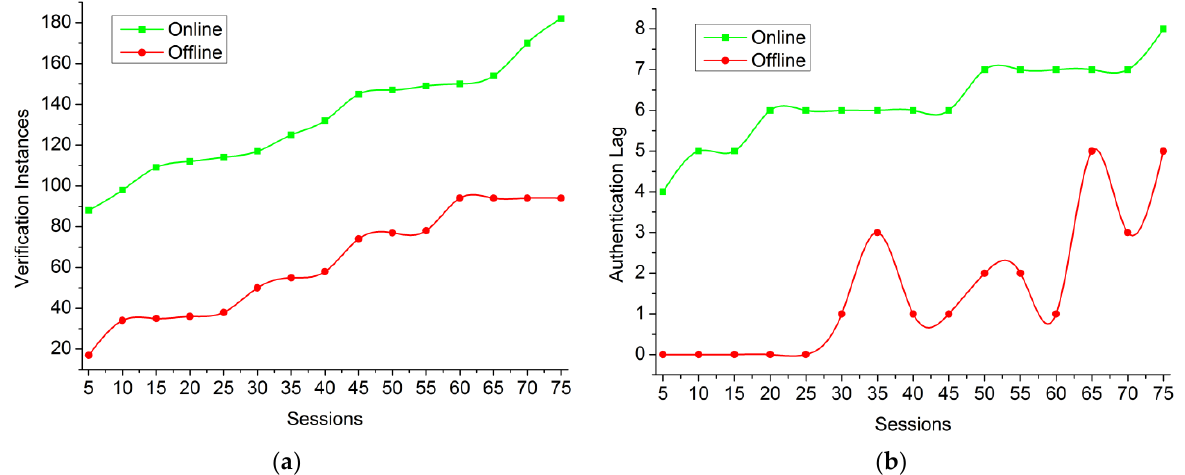
Figure 6. Verification instances and authentication lag ( a ) Verification instances Analysis for dif- ferent session ( b ) Authentication lag for different sessions. session ( b ) Authentication lag for different sessions.